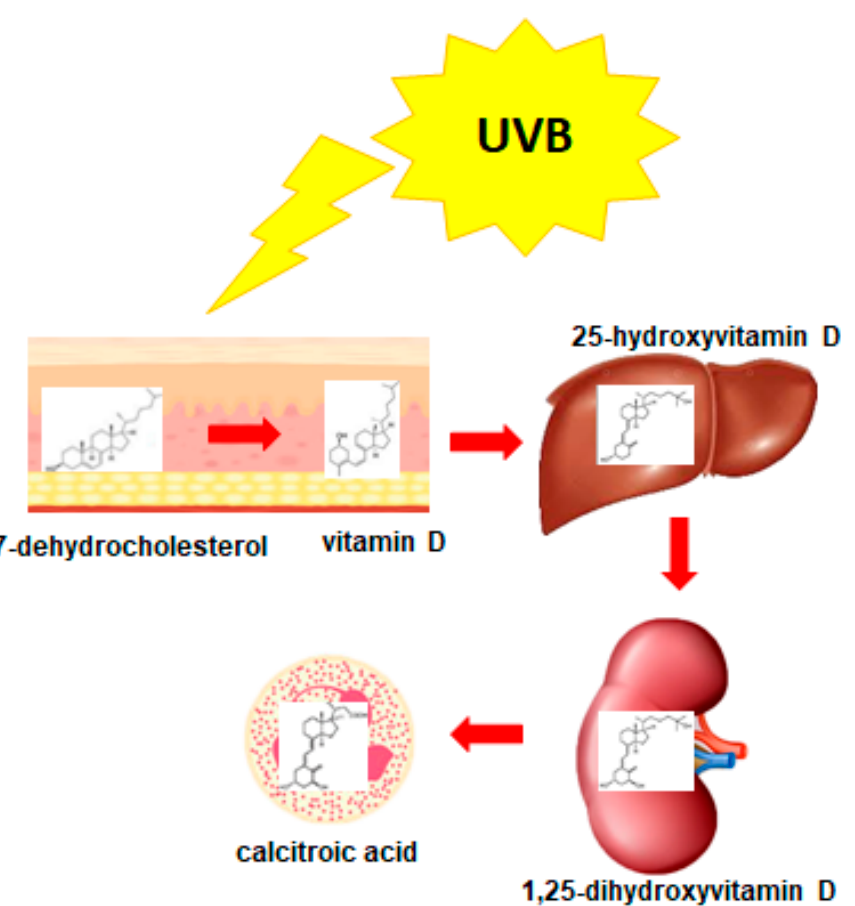
Figure 2. Vitamin D metabolism. Vitamin D is produced in human skin from 7-dehydrocholesterol following exposure to UVB. Then, vitamin D undergoes two hydroxylations: at C-25 in the liver by 25-hydroxylase, and at C-1 in the kidneys by 1 α -hydroxylase. Degradation of 1,25-dihydroxyvita- min D (1,25D) into inactive metabolite (calcitroic acid) occurs by hydroxylation at C-24 by 24-hy- droxylase in all cells which express vitamin D receptor (VDR).